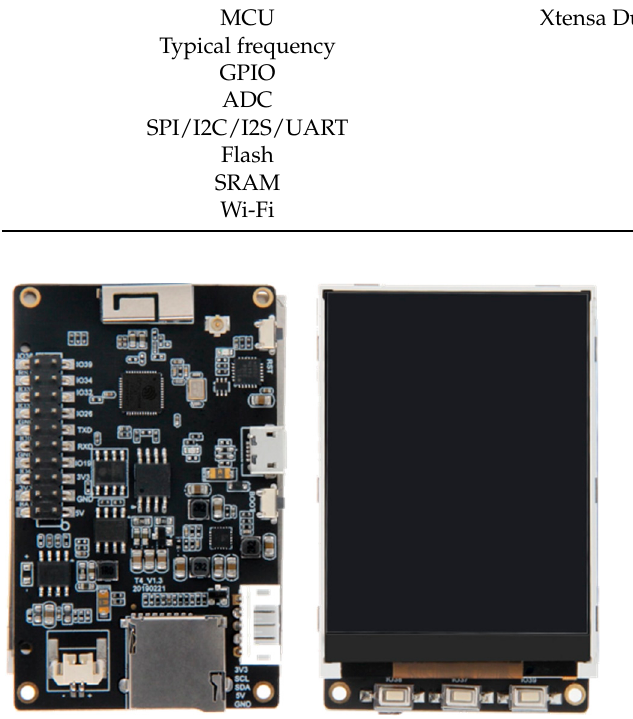
Figure 3. ESP-32 based module with integrated LCD.